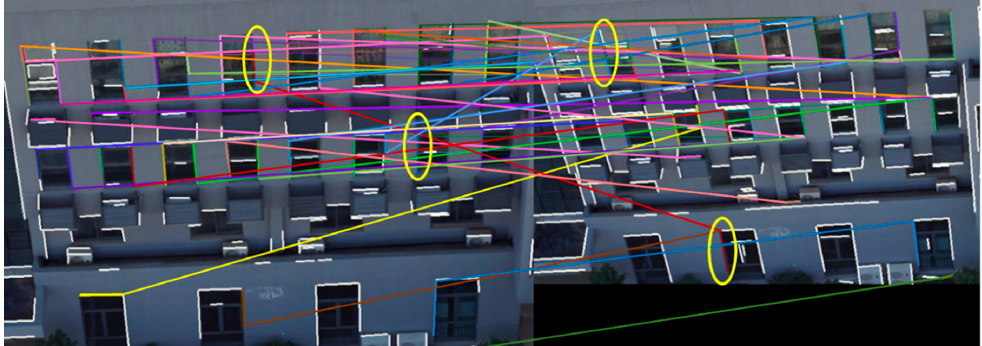
Figure 3. Illustration of missing and incorrect matching lines in the building facade areas. The white lines represent lines that failed to be matched. The lines in left and right image connected by a line with the same colour represent the matched result. The yellow ellipses in boldface denote the incorrect match pairs.